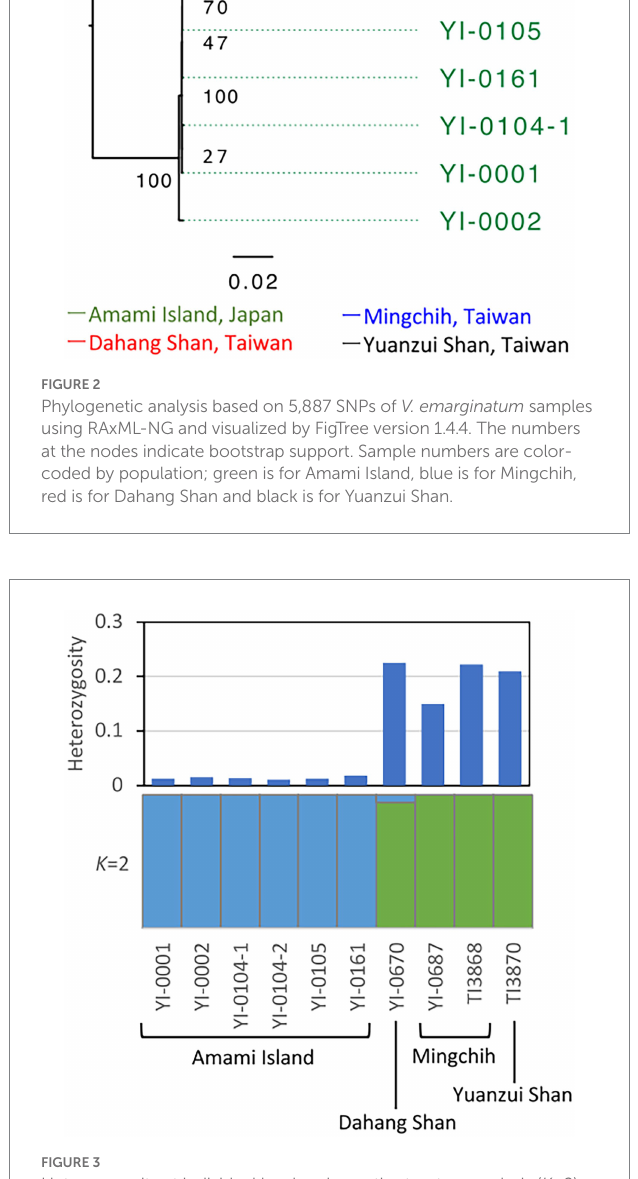
FIGURE 3 Heterozygosity at individual level and genetic structure analysis ( K = 2) of V. emarginatum on genotypes at the 4,341 SNPs. Heterozygosity at individual level was calculated by TASSEL version 5 and genetic clustering was performed by STRUCTURE version